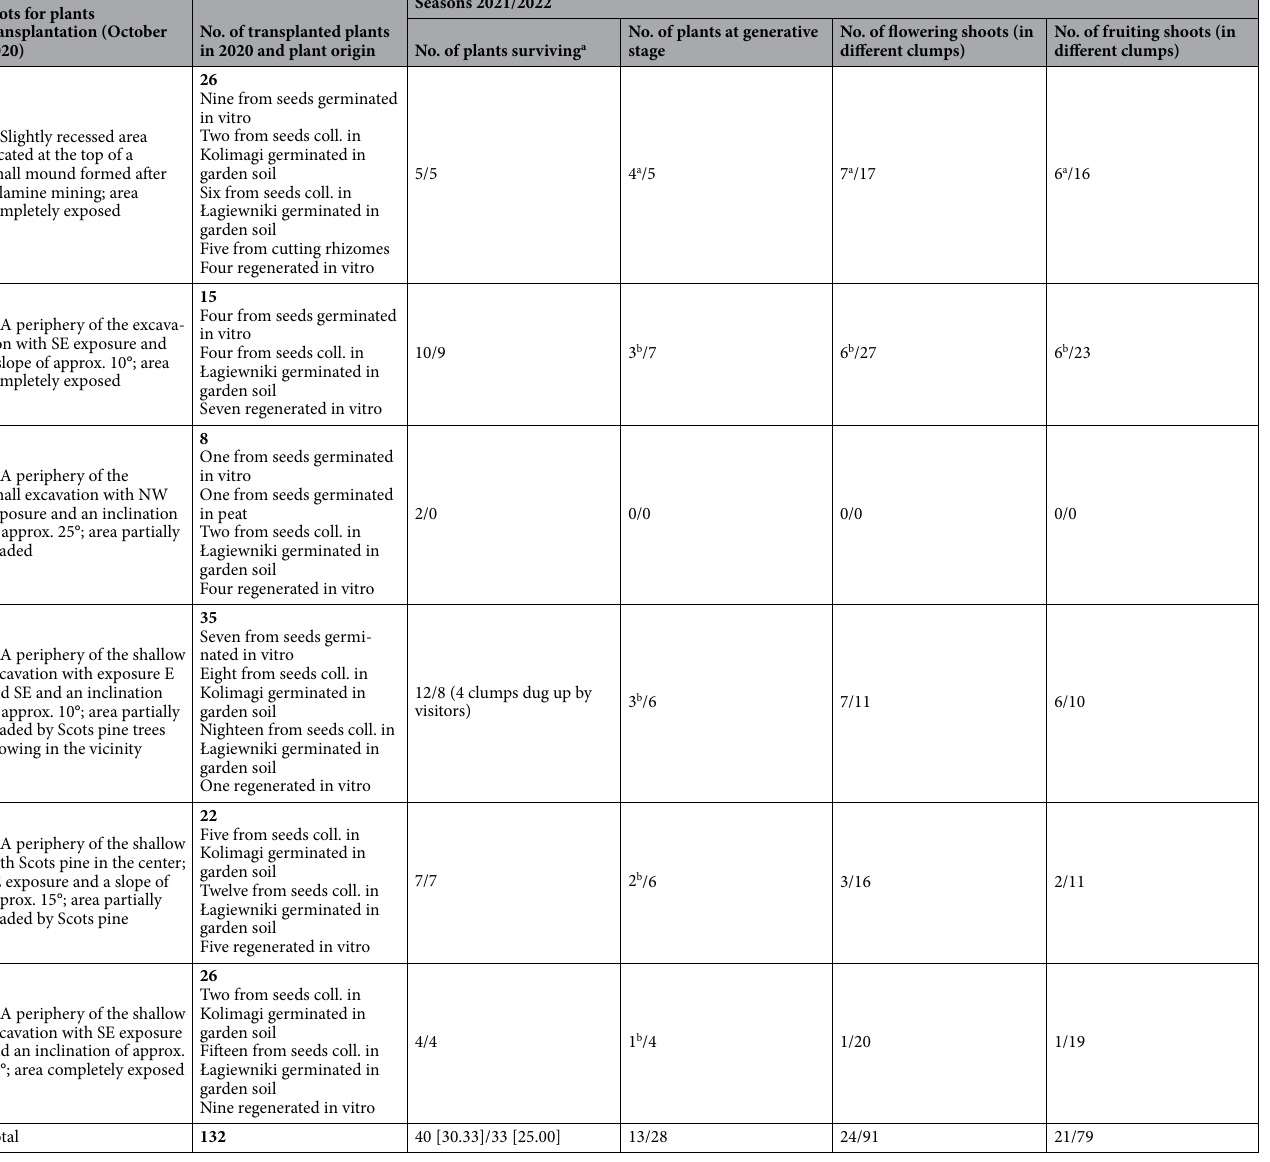
Table 5. Success of reintroduction of Pulsatilla patens on Sadowa Góra in Jaworzno—rate of surviving plants in two subsequent seasons (March/April 2021/2022) after the reintroduction. a Plants from cutting rhizomes